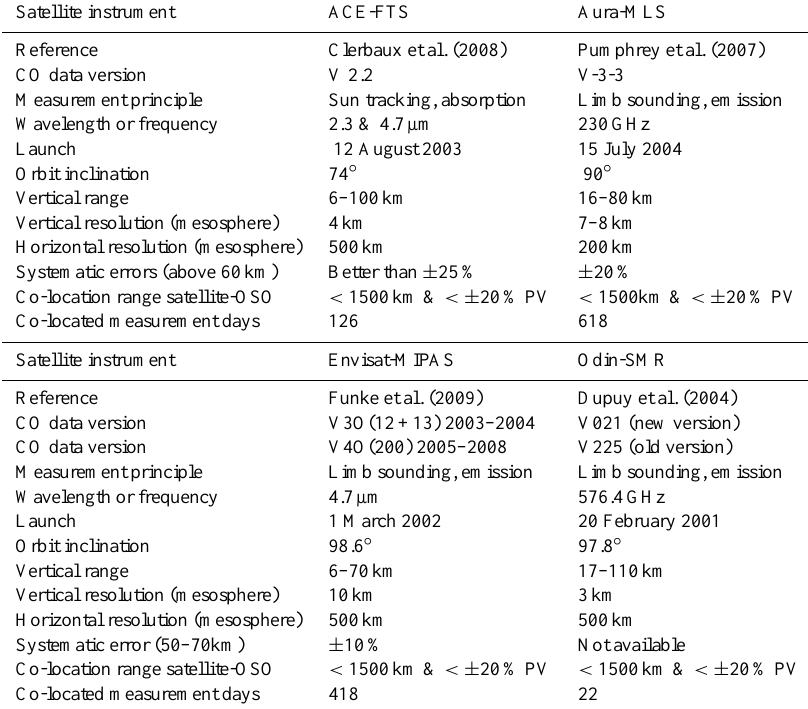
Table 3. Satellite and data characteristics.